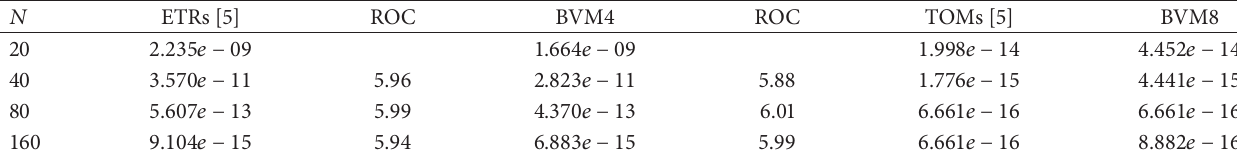
Table 7: Maximum Errors for different stepsizes for Example 5 for 𝜆 = 1 .